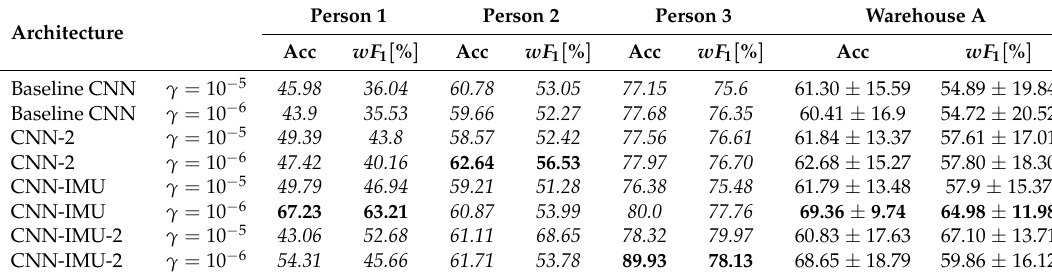
Table 13. Accuracies [ % ] and Weighted F1 [ % ] for warehouse B using CNN architectures.